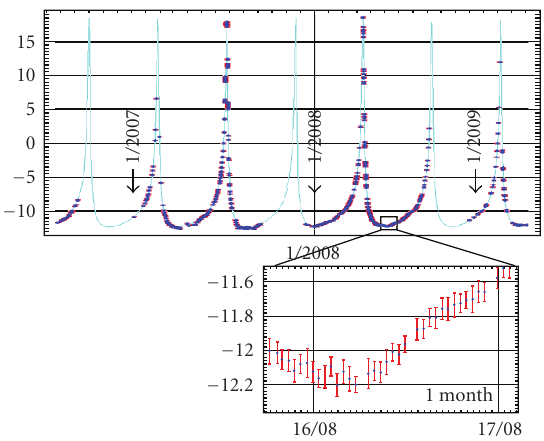
Figure 11: Radial velocities and orbit for HD123351. The star turned out to be a very eccentric single-lined spectroscopic binary with a period of 148 days. Note that its rotational period can be seen in the radial velocities due to the asymmetric distribution of its starspots.